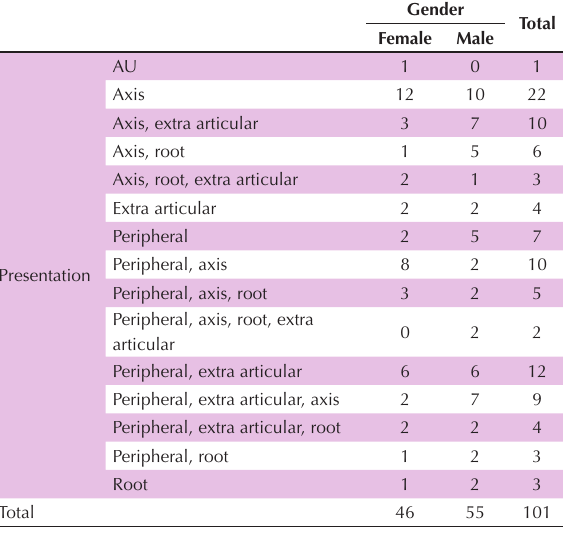
Table 7. Classification of patients based on ASDAS-ESR scoring